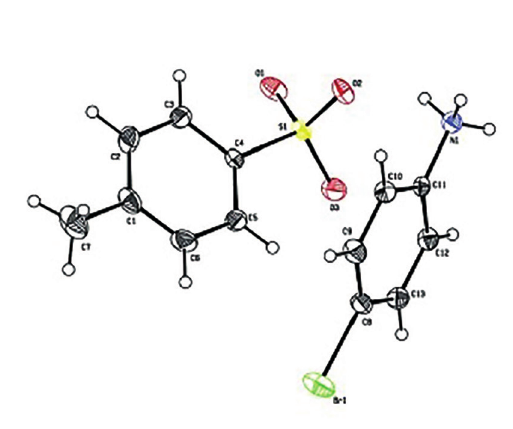
Figure 2: The molecular structure of the 4BPTS.